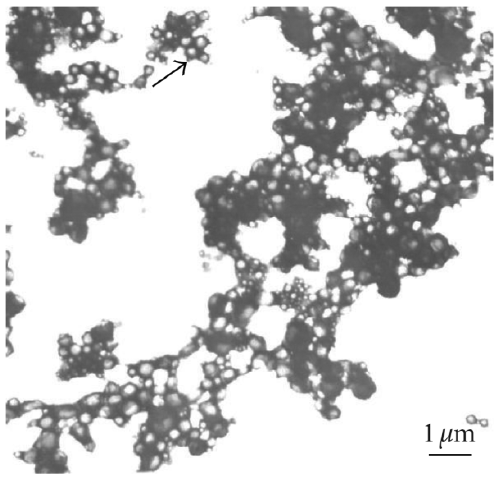
Figure 3. Transmission electron micrograph of chitosan-coated PBCA nanoparticles. The arrow points at a single nanoparticle. Reprinted with permission from ref. 143 under the terms of the Creative Commons Attribution